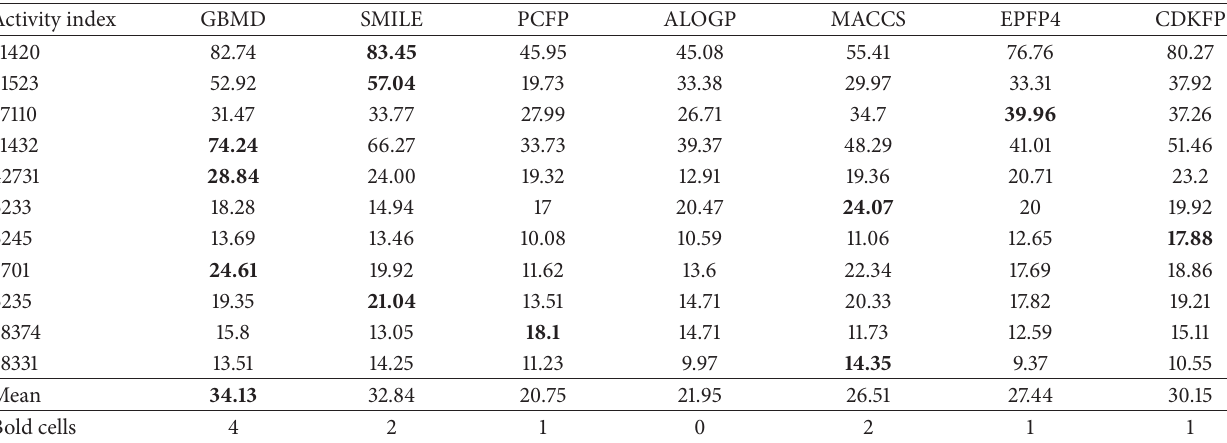
Table 5: Retrieval results of top 5% for data set DS1.